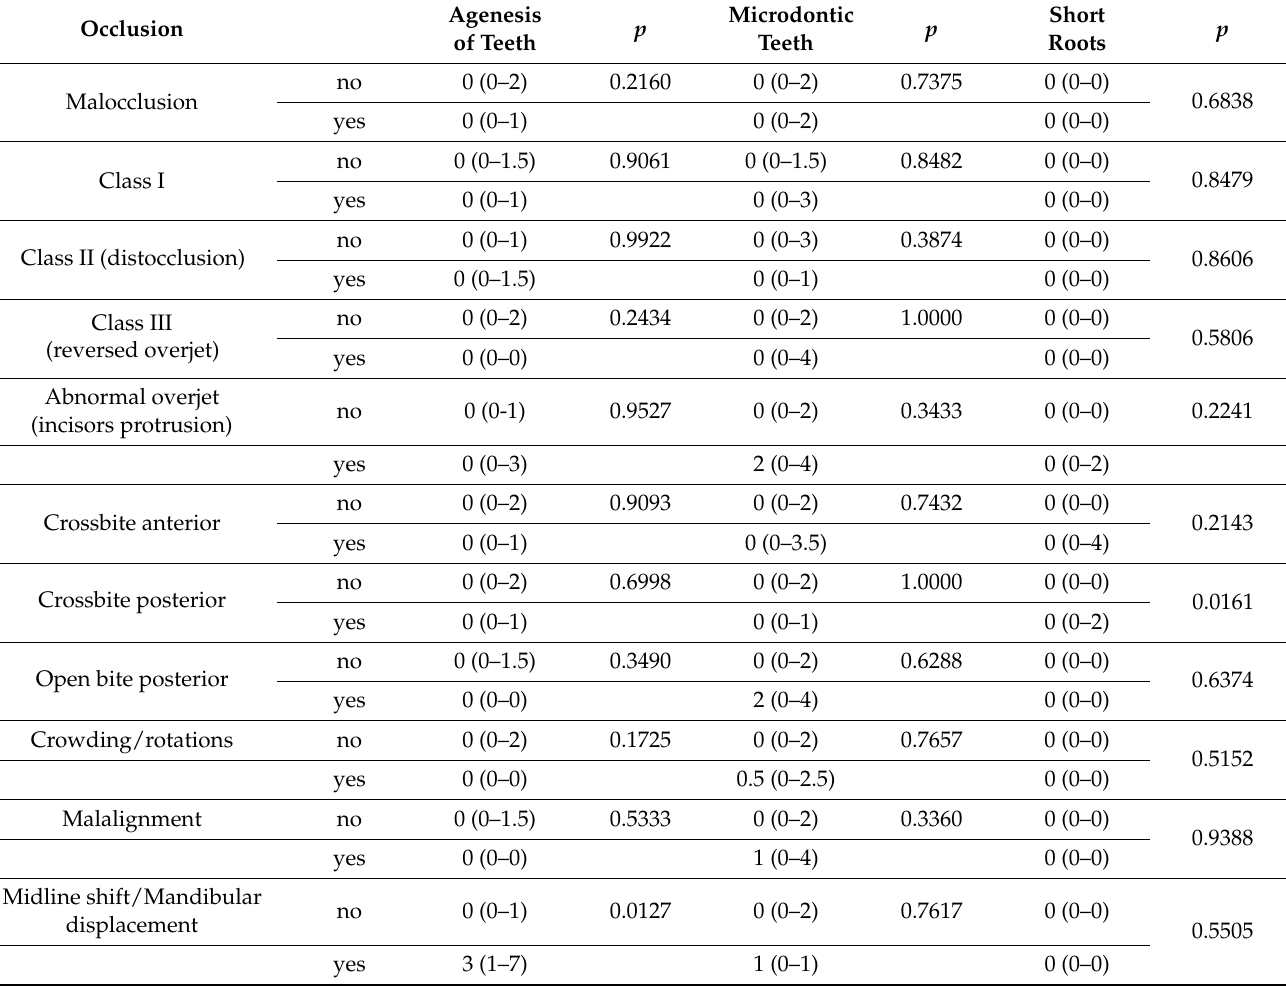
Table 3. Distribution of tooth anomalies in cancer patients with different types of dental